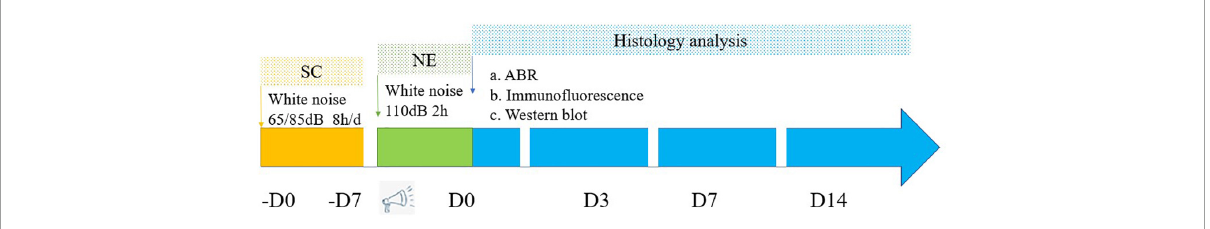
FIGURE1 Flowchart depicts the major procedures of the experiment. SC, sound conditioning; NE, noise exposure; -D0 ∼ -D7, the 65SC and 85SC groups were exposed to white noise at 65 or 85 dB SPL, respectively, for 8 h per day for 7 days; D0, after sound conditioning and immediately post-acoustic trauma; D3, after sound conditioning and at 3 day post-acoustic trauma; D7, after sound conditioning and 7 day post-trauma; D14, after sound conditioning and at 14 day post-acoustic trauma.